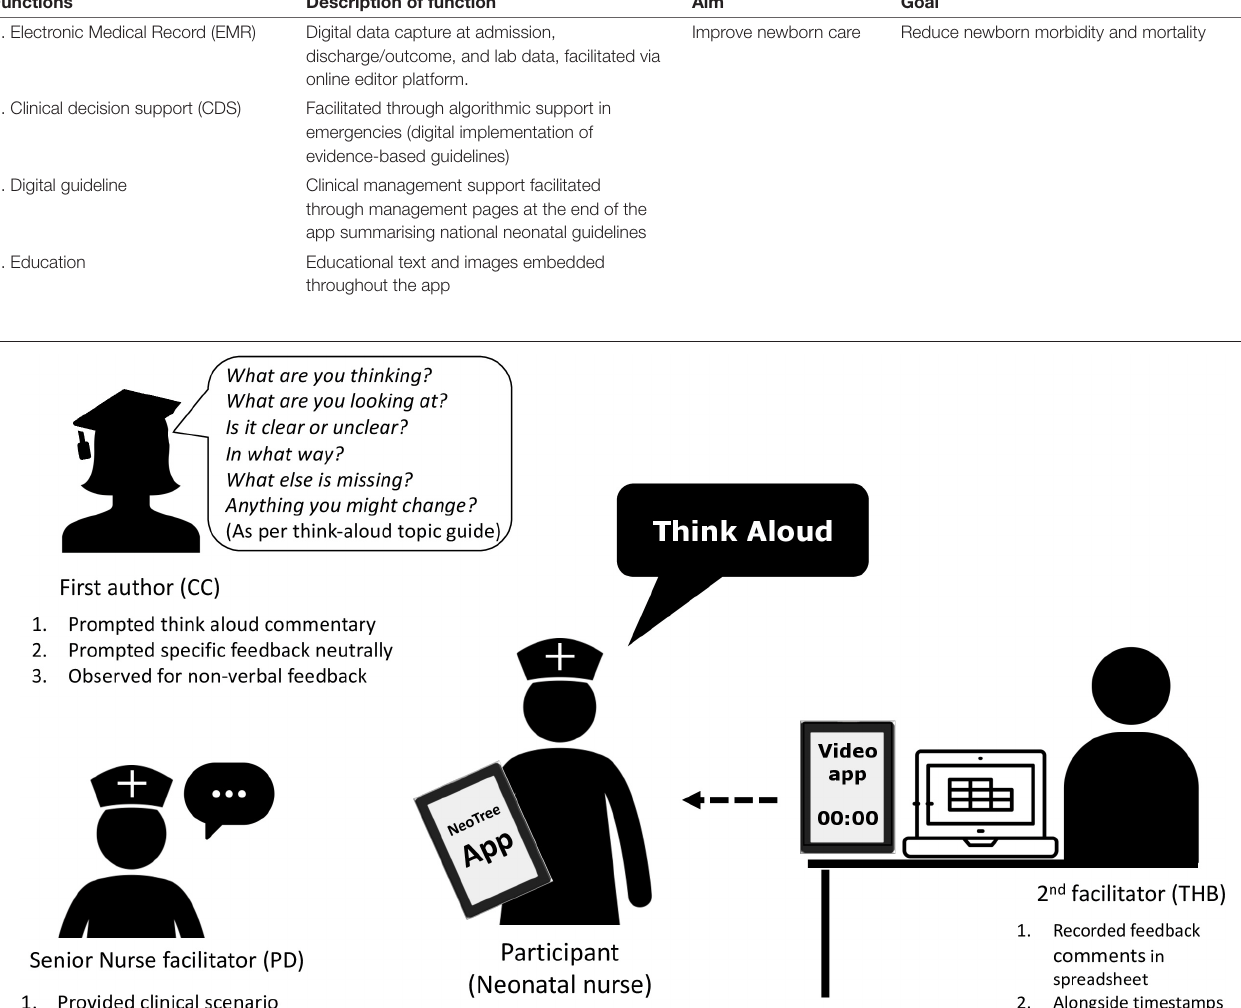
TABLE 1 | Neotree functions and purpose overview. Functions